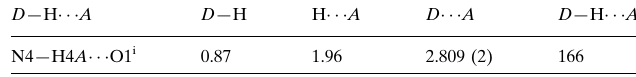
Hydrogen-bond geometry (A˚ , (cid:1)